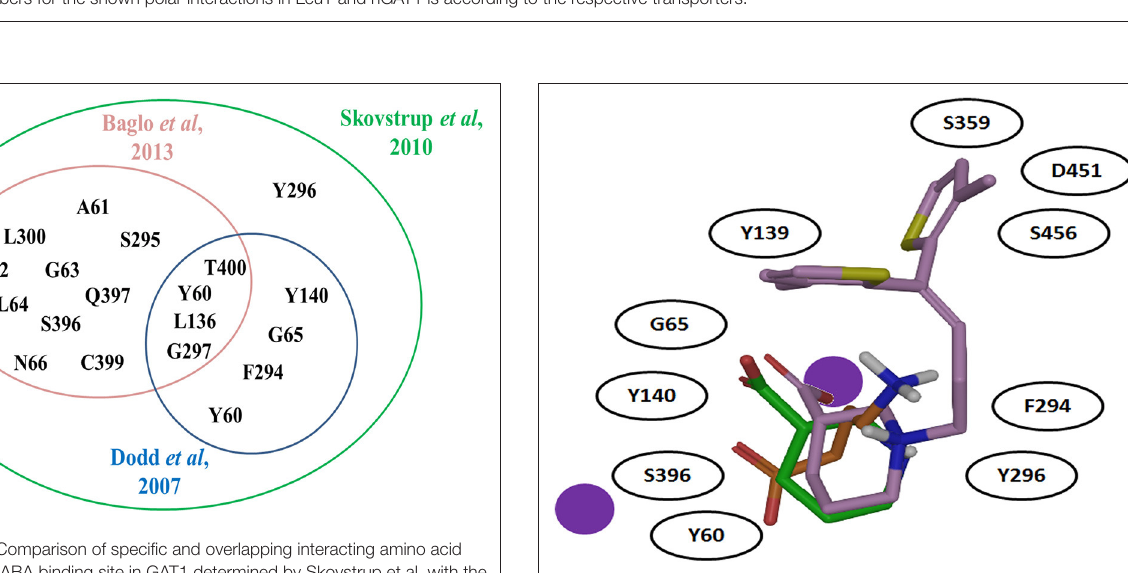
FIGURE 5 | Comparison of ligand binding site residues in (A) Leucine bound LeuT and (B) GABA bound hGAT1 [Taken and modified from Wein and Wanner (2010)]. Residue numbers for the shown polar interactions in LeuT and hGAT1 is according to the respective transporters.